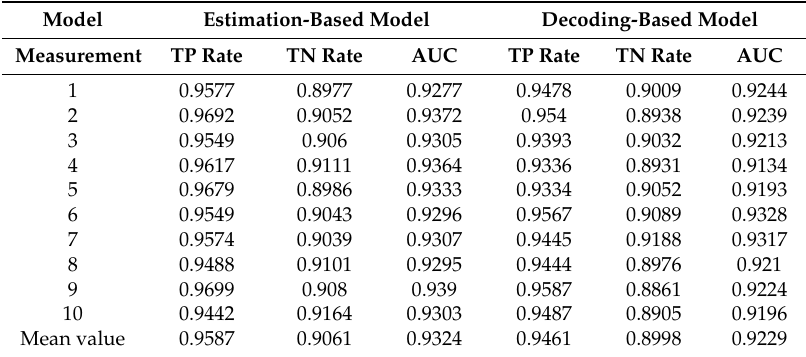
Table 5. Performance of the two models in each data group.